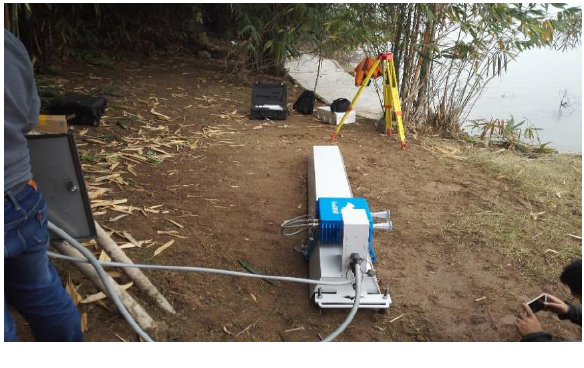
Figure 3. System erection